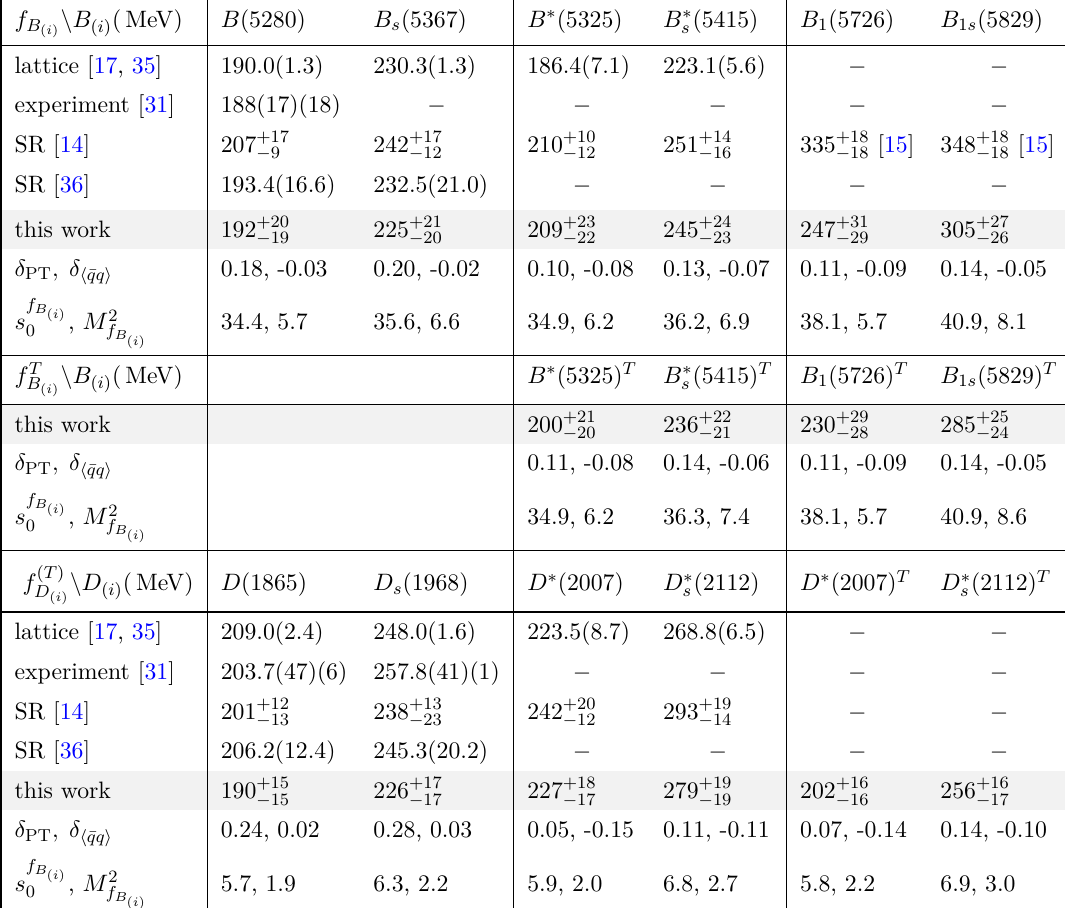
Table 8 . QCD SR results for the decay constants, in units of MeV, with the exception of the Borel parameter and the threshold which are given in GeV 2 -units. The kinetic ( µ kin = 1 GeV) and MS ( µ m = m c ( m c ) ) schemes are employed for the B - and D -meson case respectively. Input values are given in table 14. For the B ( D ) -meson SR a uniform uncertainty ∆ s 0 = ± 1 . 5 GeV 2 ( ∆ s 0 = ± 0 . 5 GeV 2 ), ∆ M 2 = ± 1 . 5 GeV 2 ( ∆ M 2 = ± 0 . 5 GeV 2 ) is applied to the threshold and